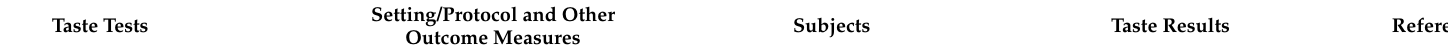
Table 3. Interventional studies included in the